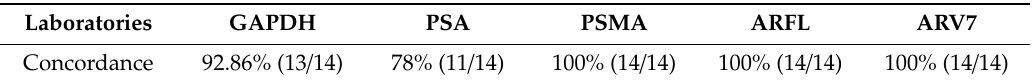
Table 3. Adna ARV7 Test concordance between two independent laboratories. Sample set consisted of 14 patient samples. Numbers in brackets indicate replicates (number of samples with concordant results / total number of samples).